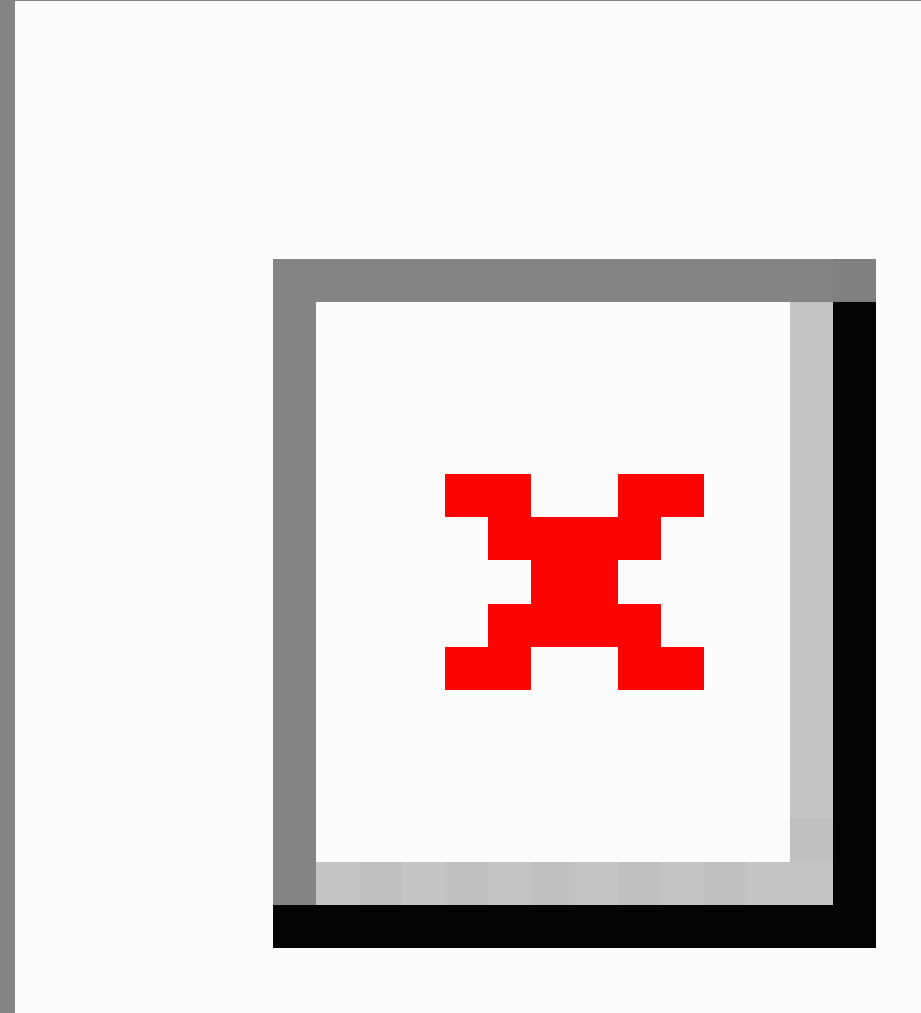
Figure 6. AYA Healthy Survivorship app: daily